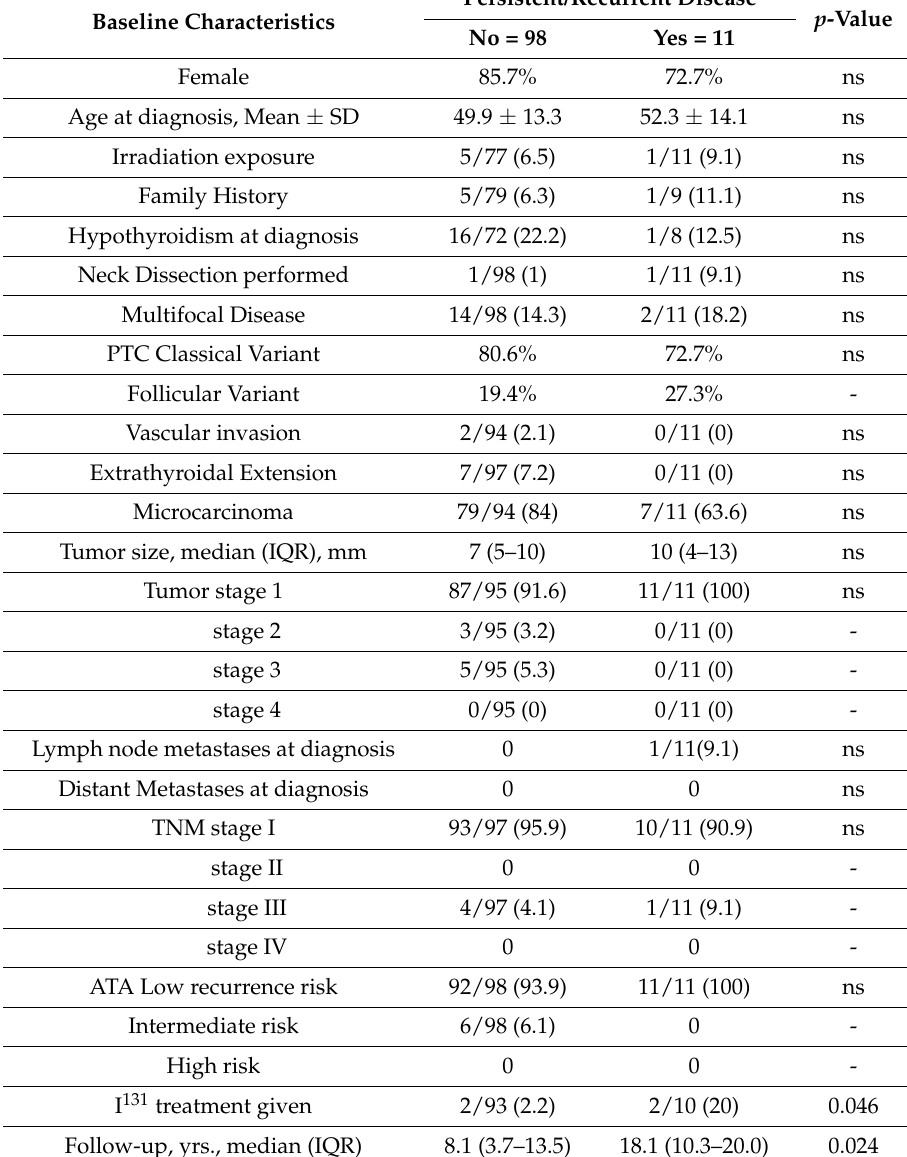
Table 5. Comparison of baseline characteristics between papillary thyroid cancer (PTC) patients with and without persistent/recurrent